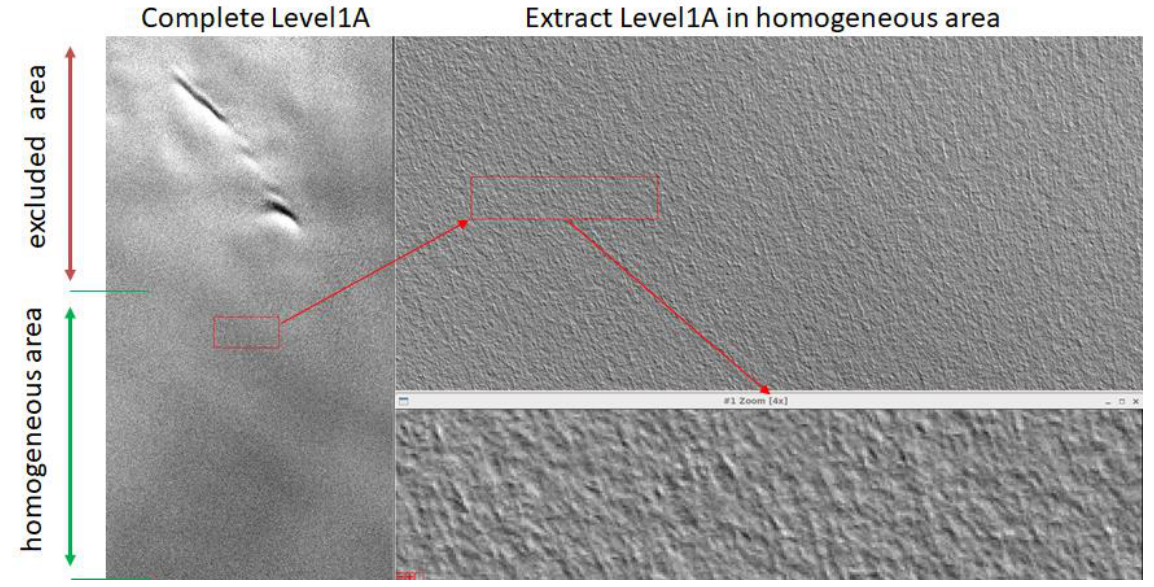
Figure 46. Homogeneous area selection for calculation.